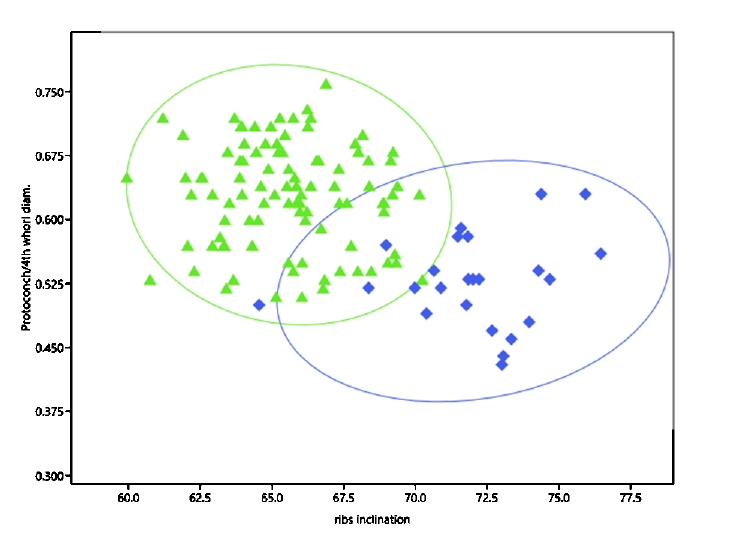
Fig. 13. Shell characters (ribs inclination and relative size of the protoconch) which could be helpful to distinguish Cochlostoma ( Clessiniella ) villae (Strobel, 1851) (blue diamonds) from Co. ( Cl. ) tergestinum (Westerlund, 1878) (green